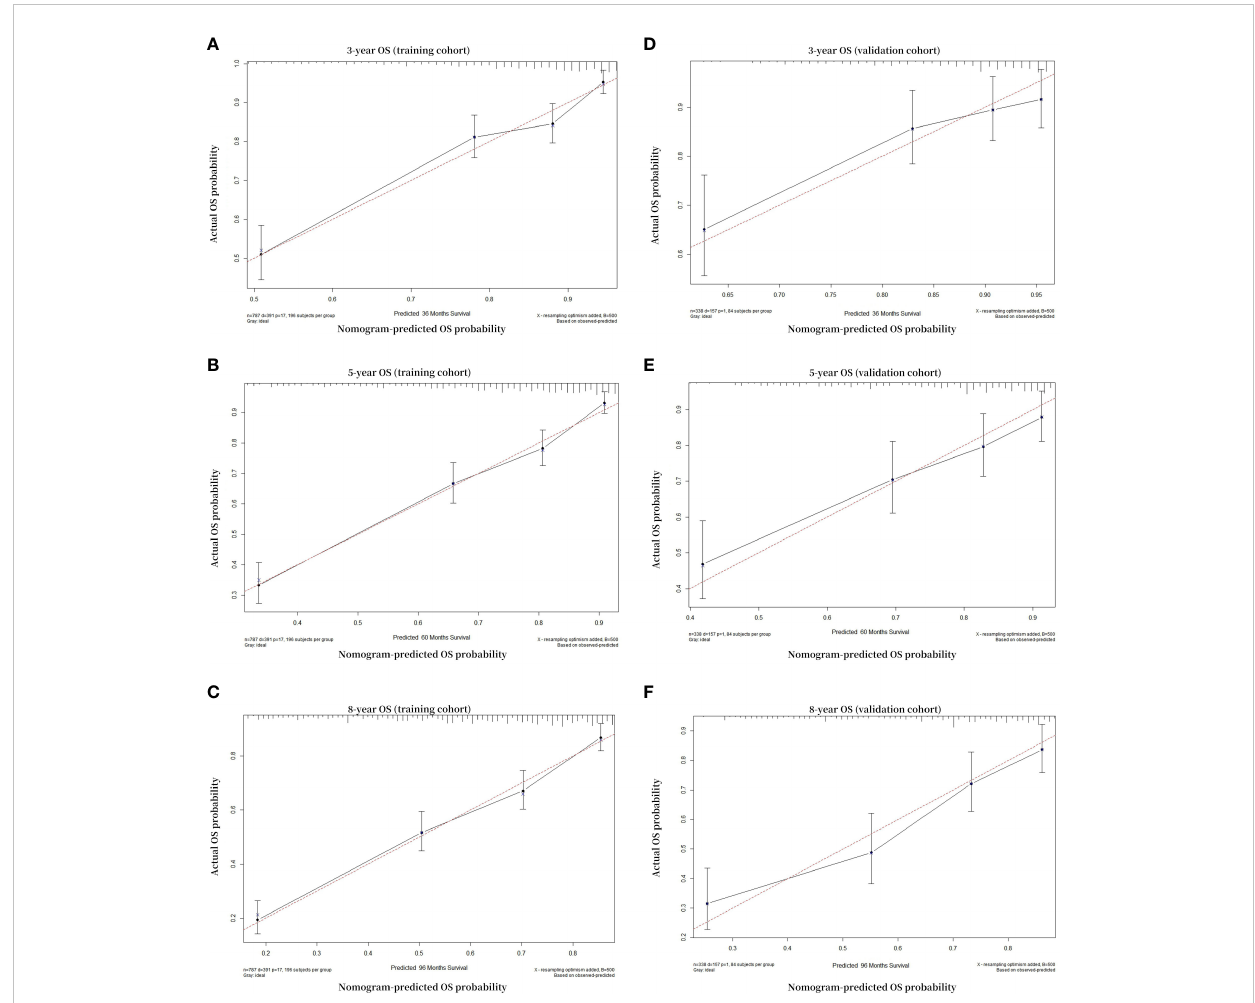
FIGURE 4 Calibration curves. Calibration curves for 3-, 5-, and 8-year OS depict the calibration of each model in terms of agreement between the predicted probabilities and observed outcomes of the training cohort (A – C) and validation cohort (D – F) . The solid black line indicates the ideal reference line where predicted probabilities would match the observed survival rates. The black dots are calculated by bootstrapping (resample: 500) and represent the performance of the nomogram. The closer the solid black line is to the dash red line, the more accurately the model predicts survival. OS, overall